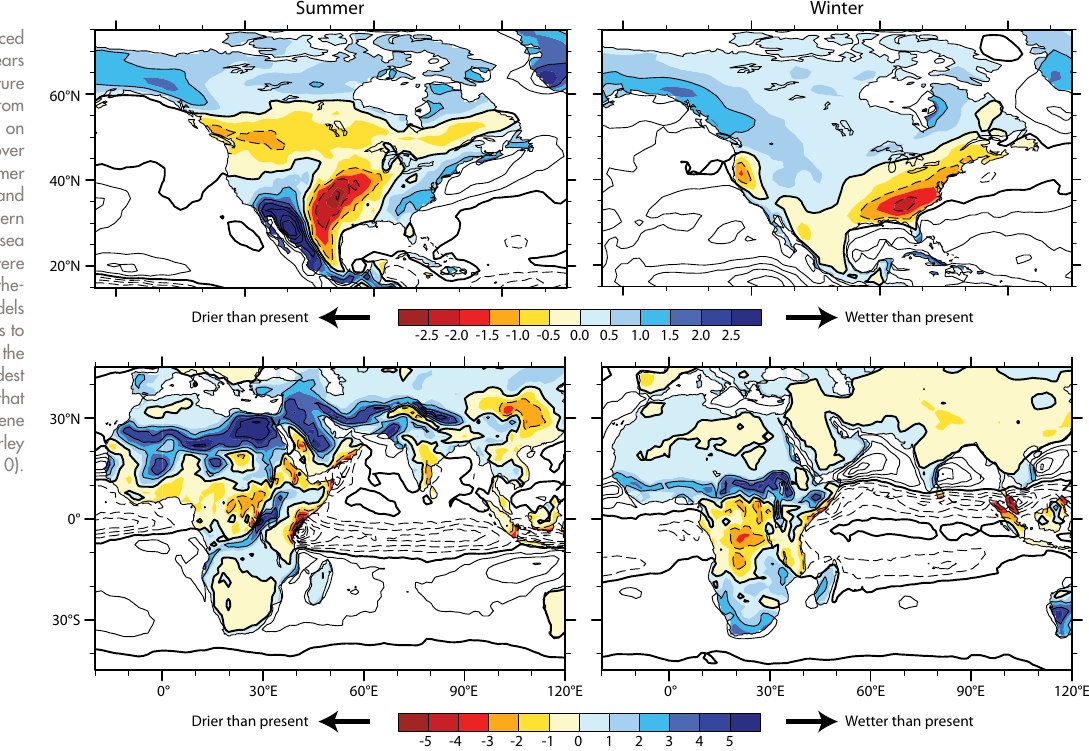
figure 2.9. impact of reduced pliocene (~4.6–3 million years ago) sea surface temperature gradients, reconstructed from deep-sea sediment cores, on precipitation (mm/day) over north america in summer and winter (top panels) and over africa and southern asia (bottom panels). The sea surface temperatures were used as input into state-of-the- art numerical climate models and make predictions as to possible outcomes on the hydrologic cycle of a modest global warming similar to that observed during the pliocene (e.g., figure 2.1). after Brierley and fedorov